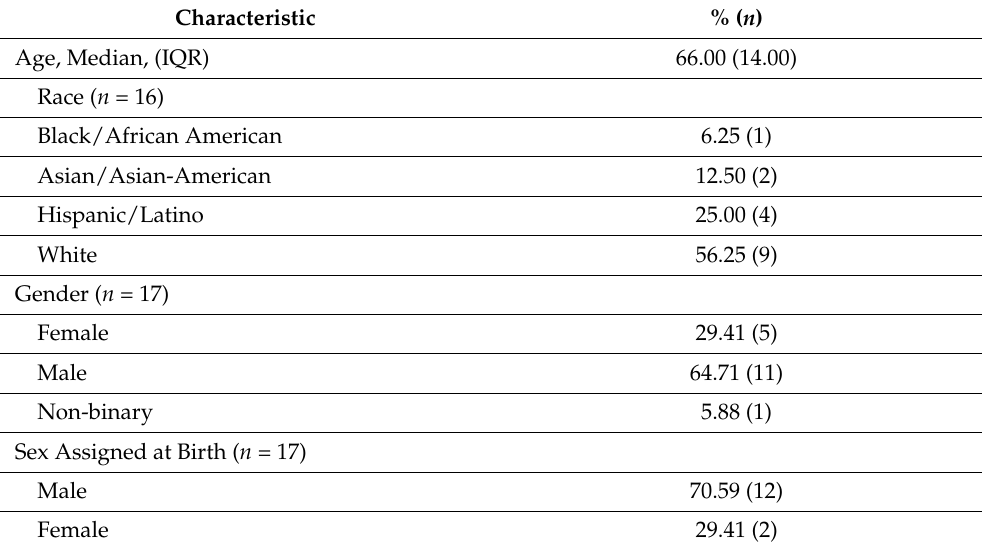
Table 1. Demographic Characteristics of